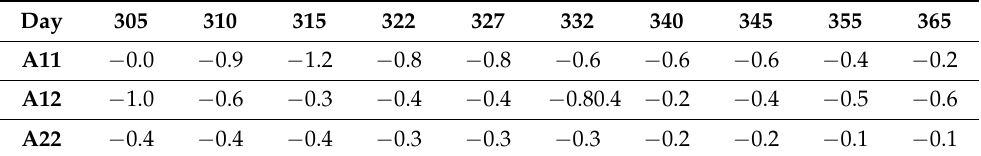
Table 1. The normalized vertical vorticity ζ /f 0 in eddies: Caucasian AE (A11), Batumi AE (A22), and at the site